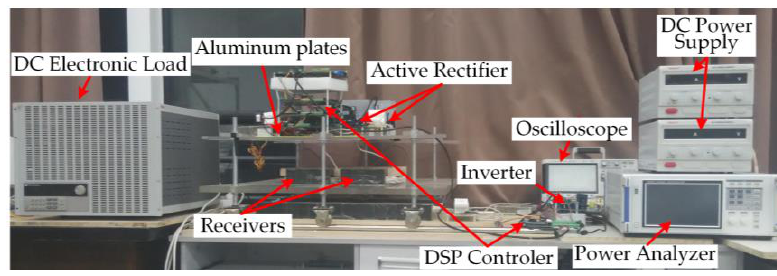
Figure 10. Experimental setup.